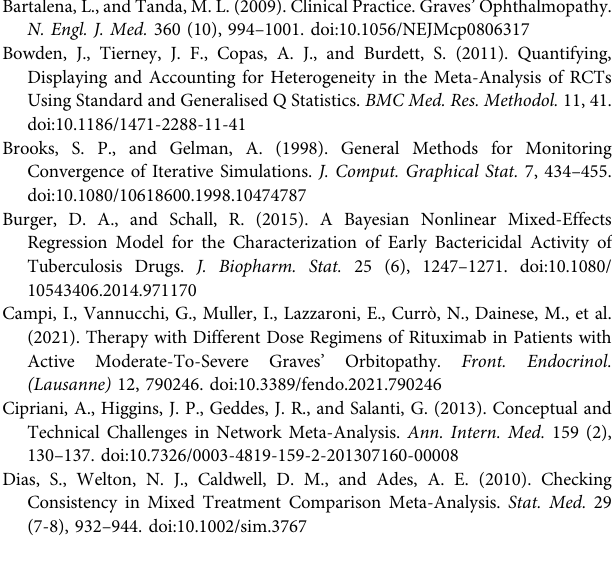
Supplementary Figure S2 | Rank probability of all studied treatment regimes for each outcome. CASC, clinical activity score change; AEs, adverse events. Supplementary Table S1 | Search strategy of target